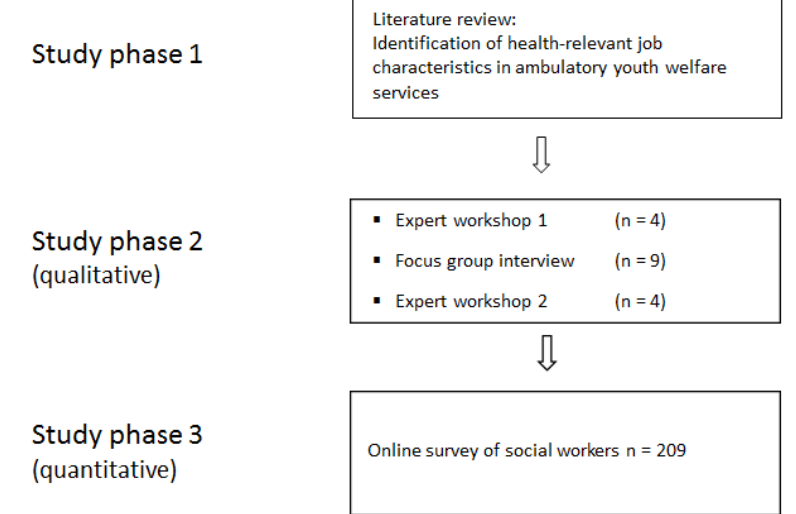
Figure 1. Identification and operationalisation of health-relevant job characteristics in ambulatory youth welfare services. 3.1. Systematic Literature Review: the Occupational and Health Situation in Ambulatory Youth Welfare Services